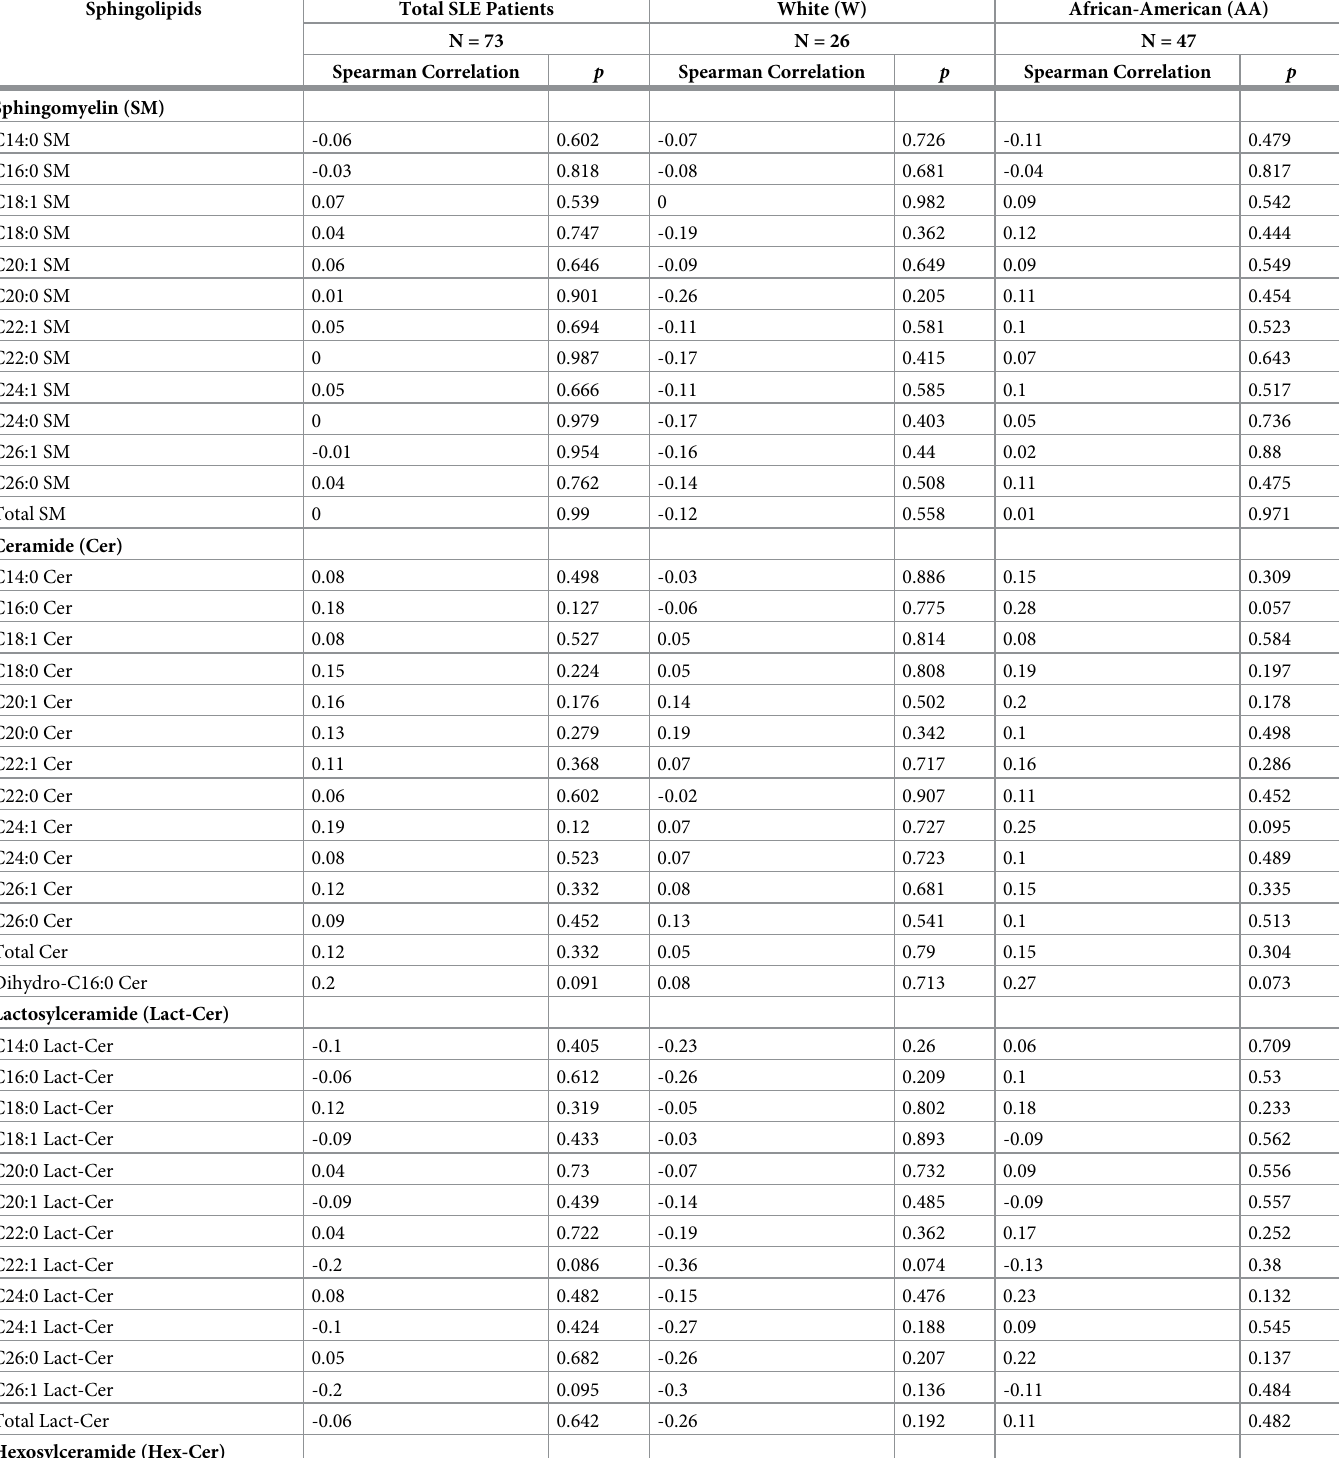
Table 6. Correlation of sphingolipid concentration with Systemic Lupus Erythematosus Disease Activity Index (SLEDAI) score for White and African-American SLE